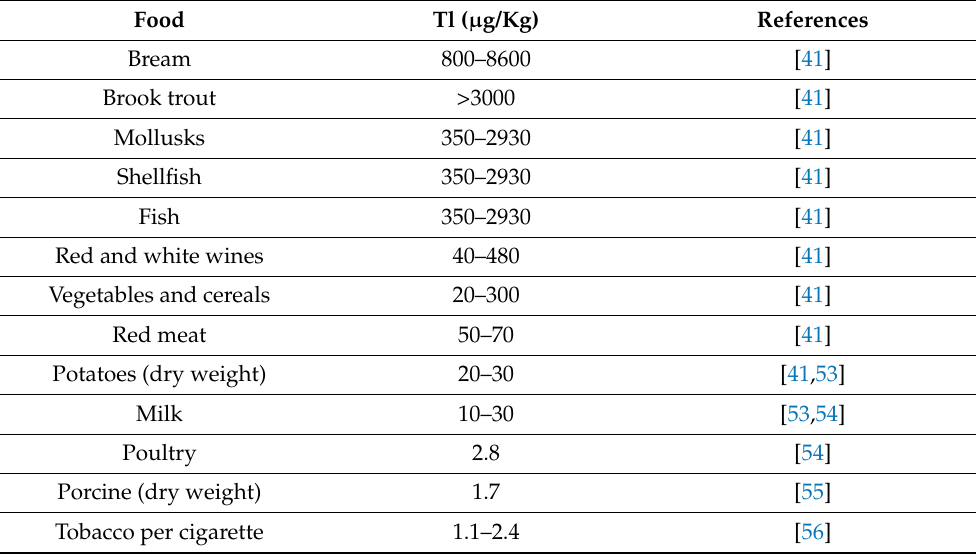
Table 3. Food sources of